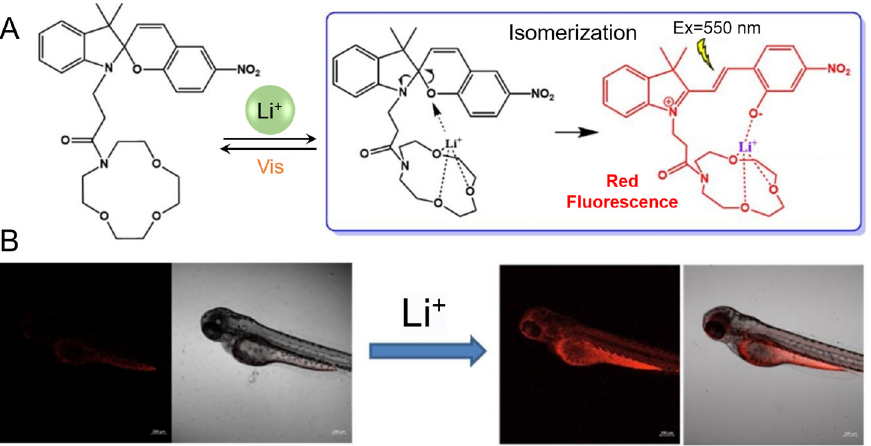
Figure 13. ( A ) Li + fluorescent probe (spirobenzopyrans crowned ether, SP-CE) for in vivo detection of Li + . ( B ) CLSM images of zebrafish treated by exogenous Li + . Reproduced from [180] with permission from Elsevier, copyright 2019.